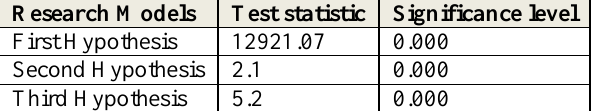
Table 9. The results of the inequality test of